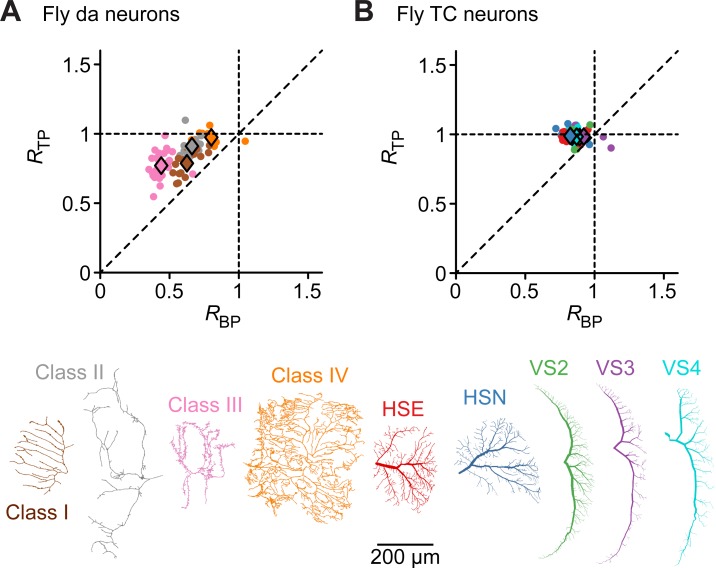
R values of fly da neurons and TCs subdivided into individual classes.A. Similar plots as in Fig 2 but subdividing da neurons into their four different classes (I-IV). B. Similar subdivision as in A but for fly TCs. Here the five different cell types exhibit similar R values. Individual morphologies are shown to visualize the differences in how regularly the branches are distributed in the different classes.